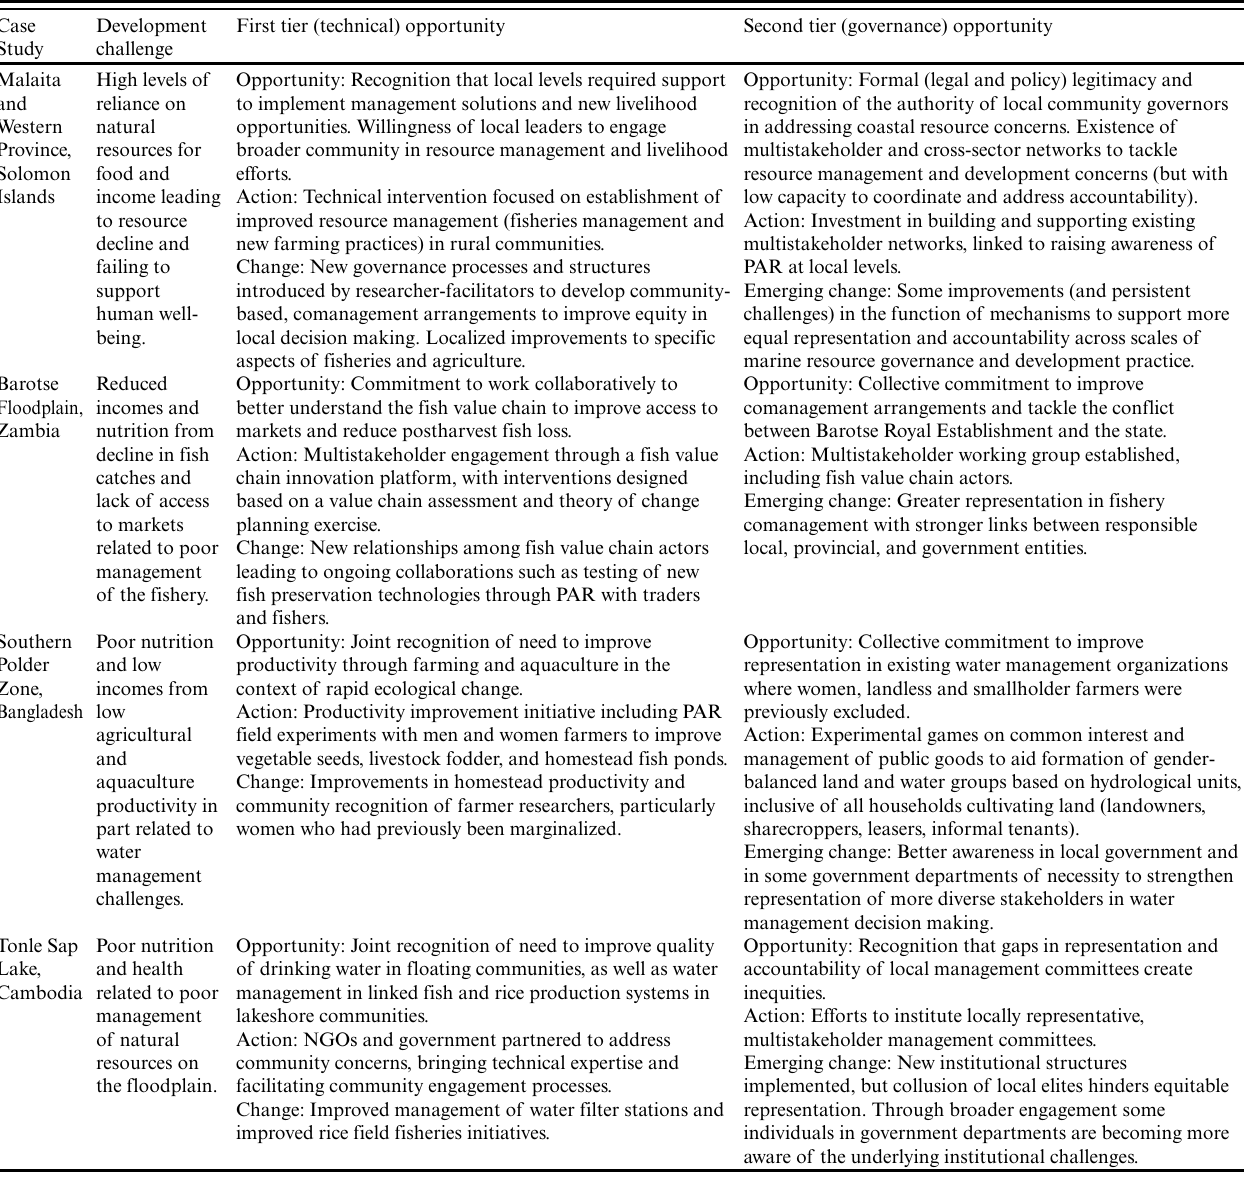
Table 2 . Windows of opportunity and emerging changes in each of the